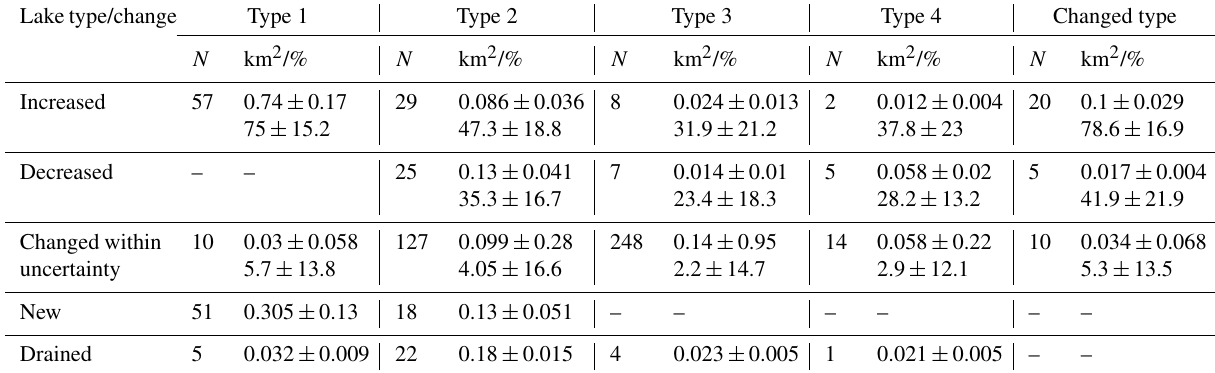
Table 4. Changes in number ( N ) and combined area of lakes of different types. For each category, the upper and the lower lines show the absolute (km 2 ) and relative (%) changes respectively. Lakes classified as Type 1 in 2002 and Type 2 in 2014 are shown separately as the “changed type”